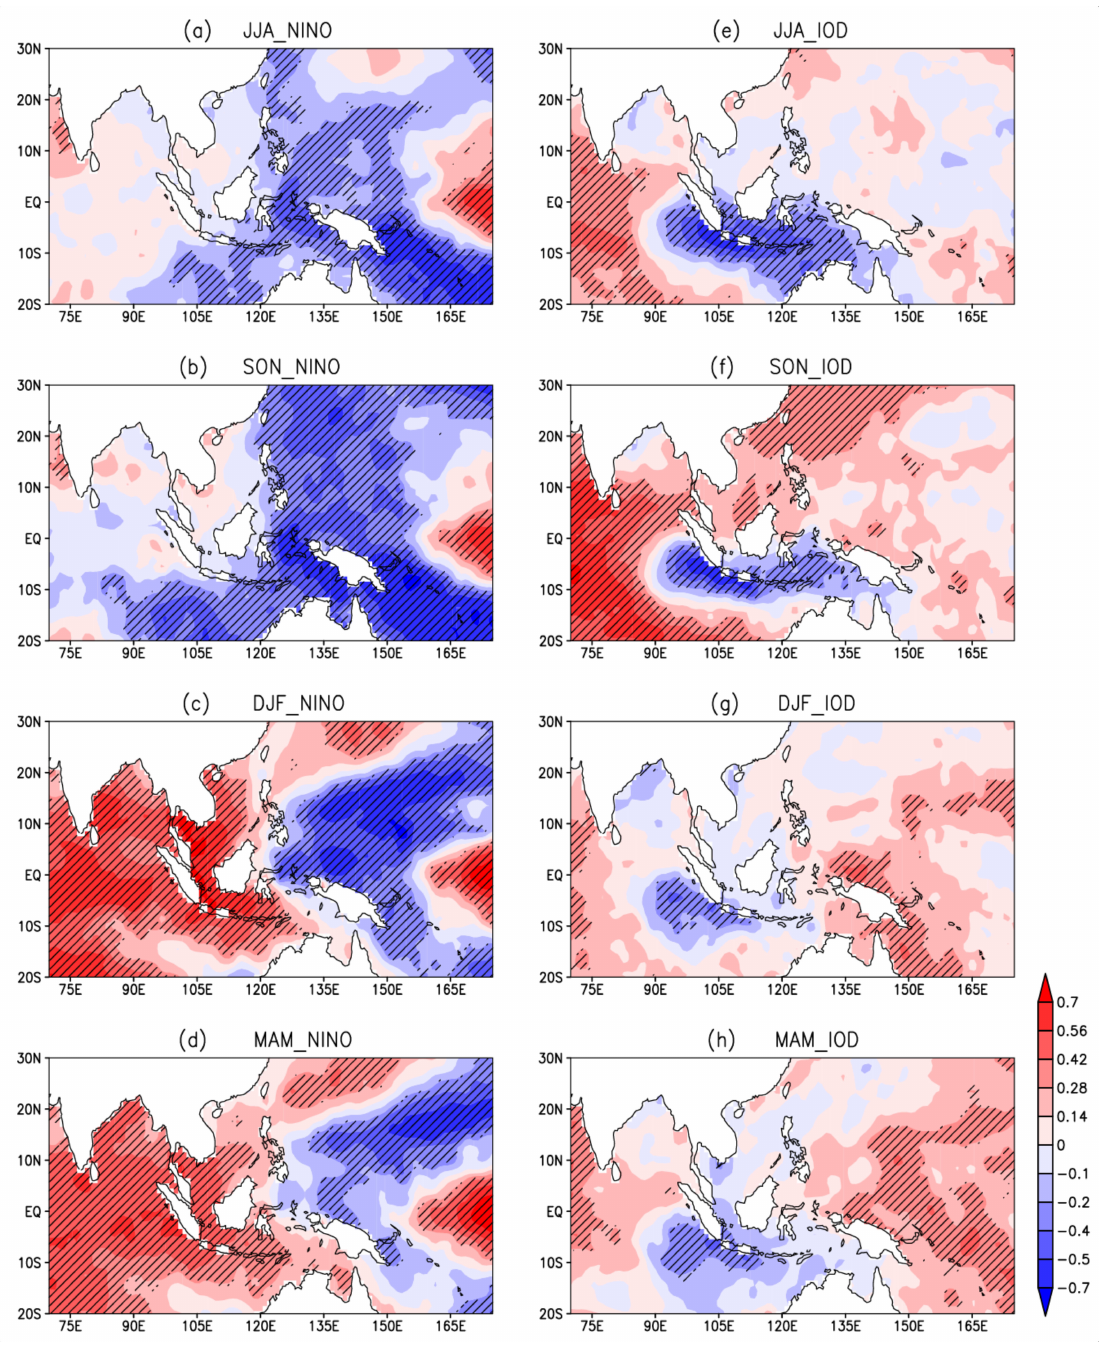
Figure 4. [Left panel] ( a – d ) Partial correlation between the SST anomalies and Niño3.4 after removing the IOD signal, [Right panel] ( e – h ) partial correlation between the SST anomalies and DMI index after removing the Niño3.4 signal for the season of JJA, SON, DJF, and MAM. The hatched area indicates significance at the 95% level. Unit is degrees